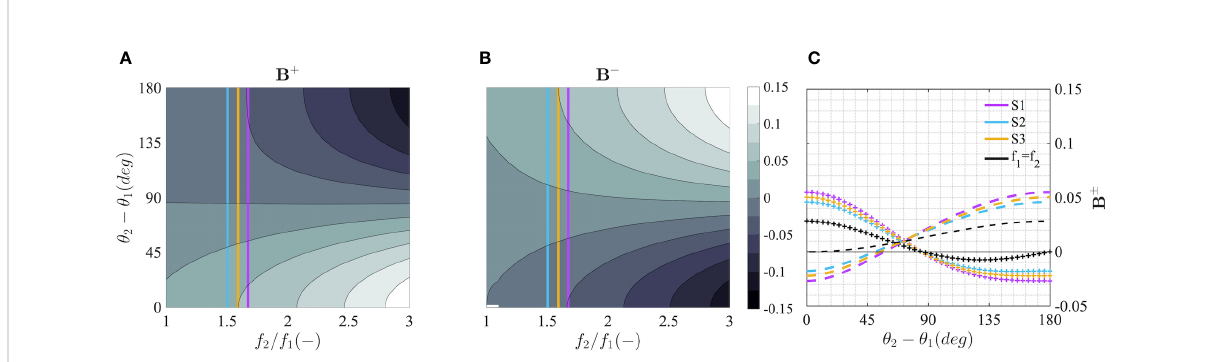
FIGURE 13 (A, B) Second-order sum (B+) and difference (B-) interaction kernels. The value of the ratio between wind sea (system 2) and swell (system 1) mean frequencies for sea states S1 (purple), S2 (cyan) and S3 (yellow) is also shown. (C) Section of the sum (crossed lines) and difference (dashed lines) interaction kernels taken at the mean frequency ratio value for the three sea states and for the simple case of f 1 = f 2